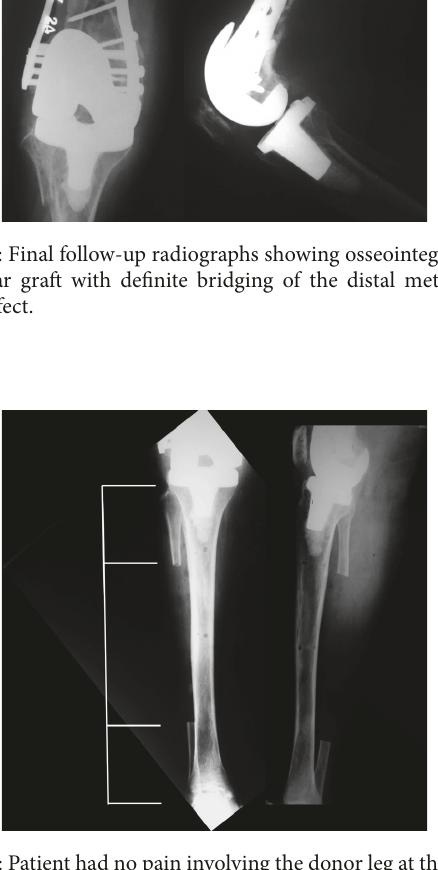
Figure 4: Patient had no pain involving the donor leg at the time of the most recent follow-up examination. Note the large resection of the fibular